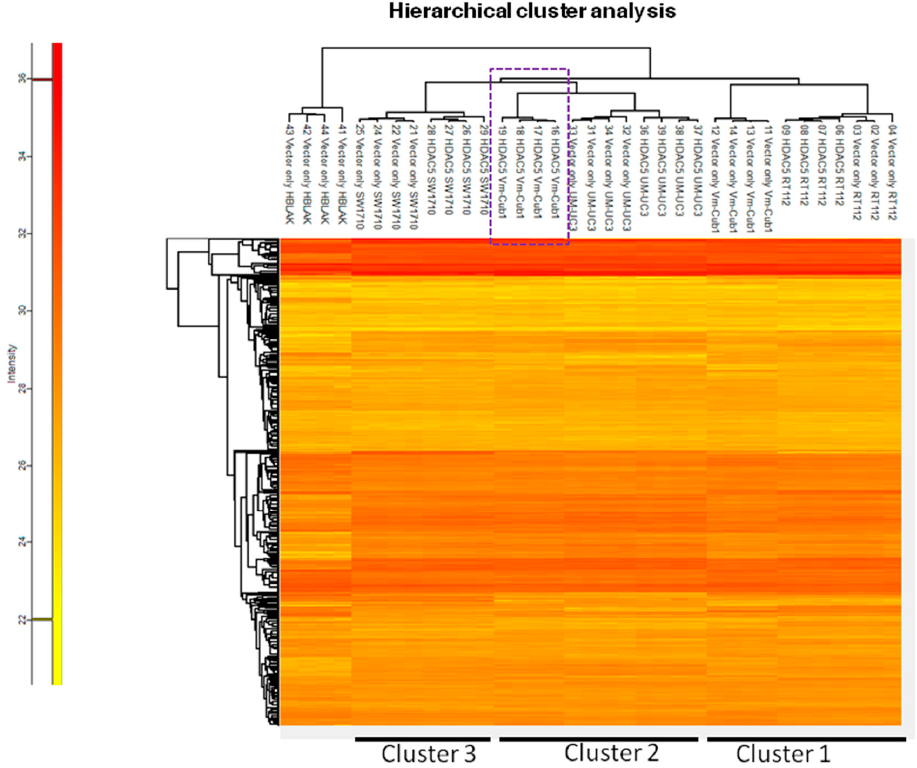
Figure 7. Hierarchical cluster analysis of proteome changes in UC cell lines transduced with vector only or HDAC5. HBLAK cells transduced with vector only were used as an outlier reference in this analysis.